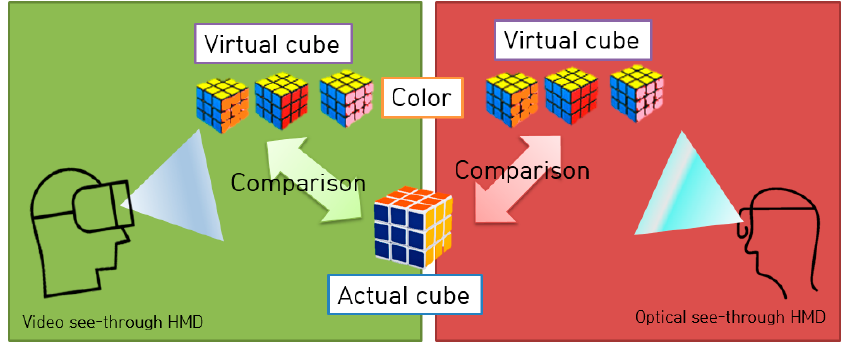
Figure 9. We investigated users’ color perceptions when comparing a real cubic puzzle and a virtual one, using the video see-through and optical see-through HMDs.